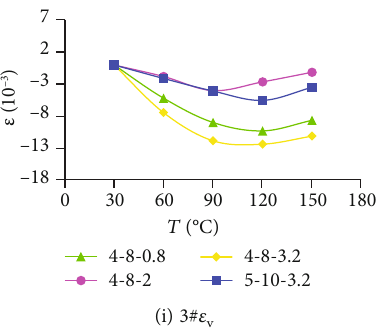
Figure 4: Relationship between coal deformation and temperature under di ff erent stress states.